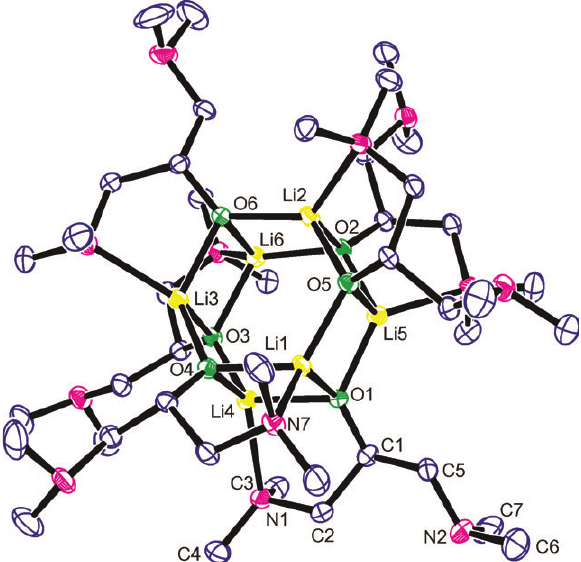
Figure 1 The asymmetric unit of 1 showing the labelling scheme used; thermal ellipsoids are at the 40% probability level. Metrical data around Li(1) and O(1) as representative: Li(1)-O(1) 1.957(4), Li(1)-O(4) 1.936(4), Li(1)-O(5) 1.887(4), Li(1)-N(7) 2.171(5),